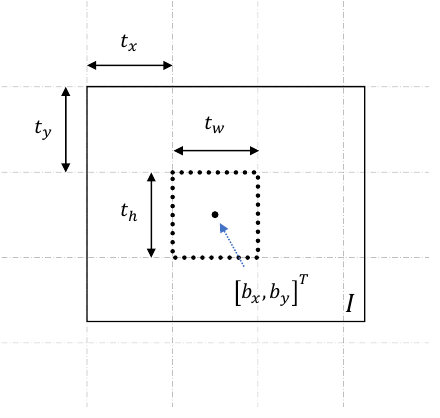
Figure 2. Sketch of the bounding